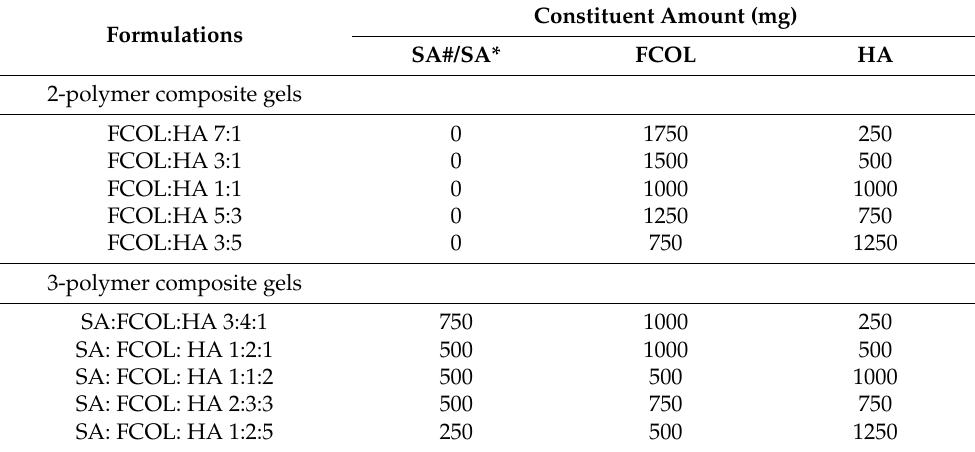
Table 1. Composition of biopolymers used to prepare 2% composite FCOL:HA and 2%. SA:FCOL:HA gels including D-mannitol as a cryoprotectant at 20% of total polymer weight for BSA-loaded gels.